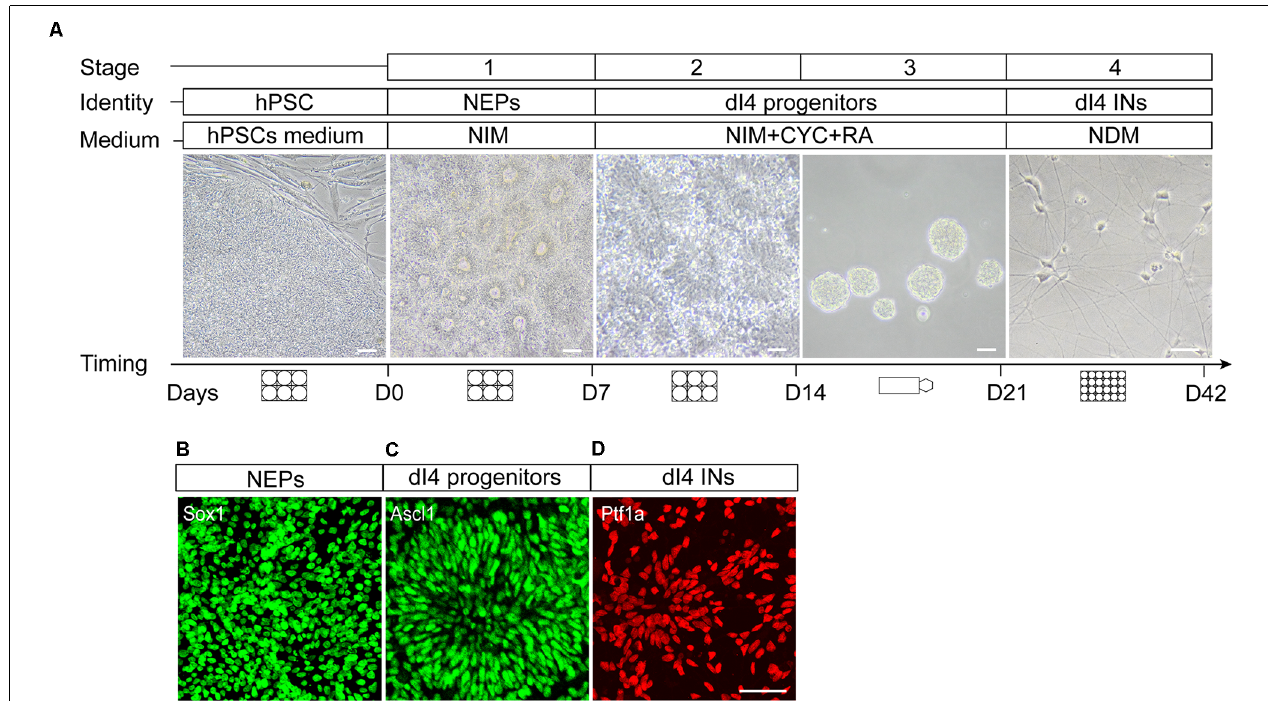
FIGURE 2 | In vitro differentiation protocol of spinal dI4 INs from hPSCs. (A) Cartoons showing the four stages of the differentiation and corresponding culture vessels, medium types, culture duration, and the morphological features under a phase contrast scope. (B–D) Characteristic antigenic expression in different stages of neural differentiation, Sox1 in neuroepithelia at day 7 (B) , Ascl1 in the dorsal spinal dI4 progenitor (C) at day 15, and Ptf1a in maturing dI4 INs (D) at day 22. D, day; Scale bar, 50 µ